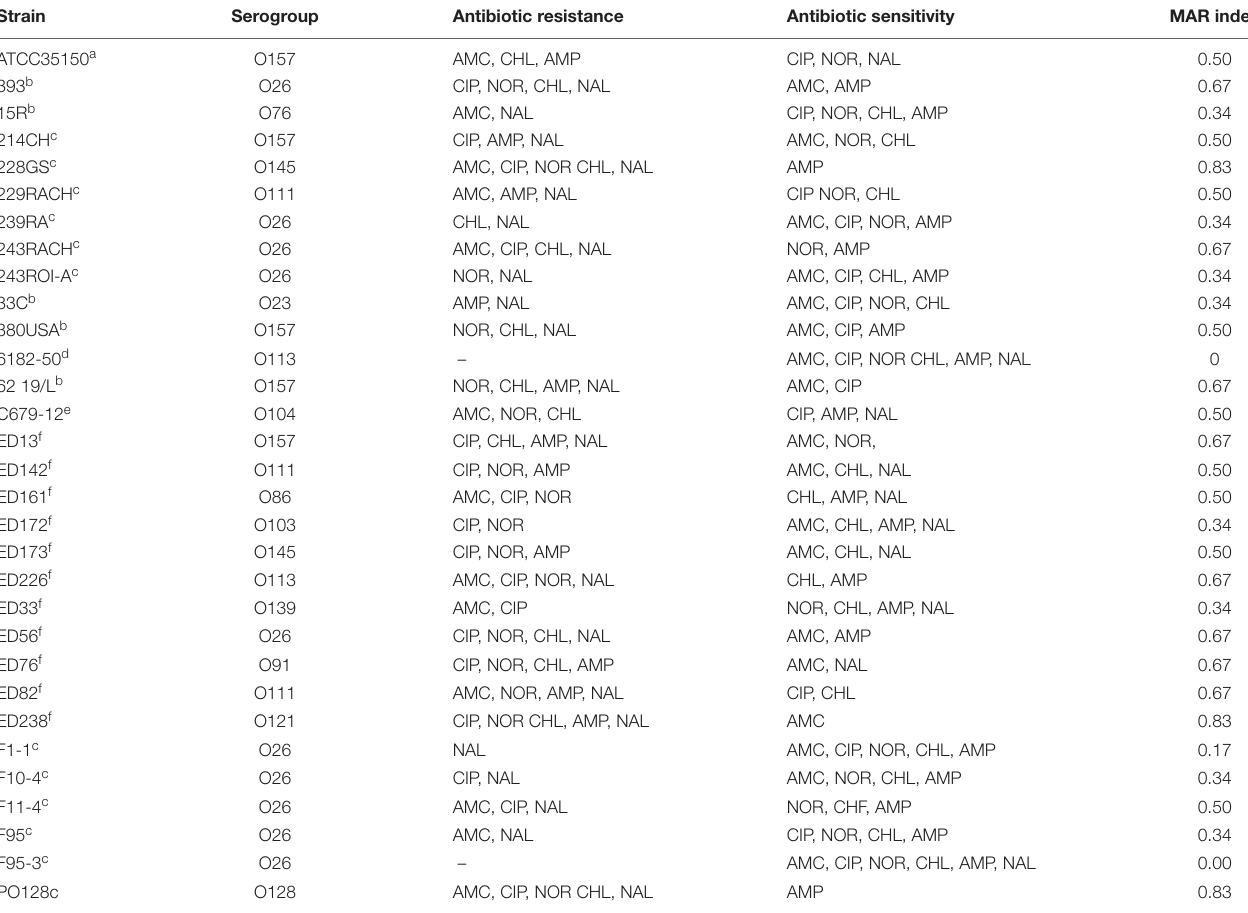
TABLE 1 | STEC strain used in this work with information relative to antibiotic resistance according to EUCAST (2019). Strain Serogroup Antibiotic resistance Antibiotic sensitivity MAR